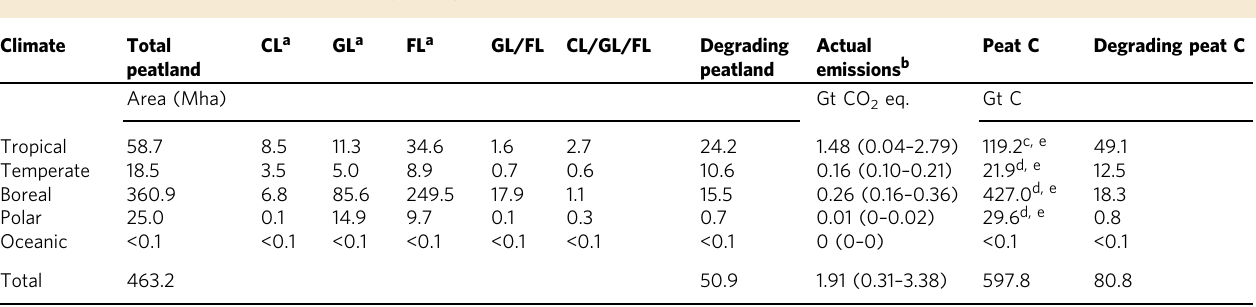
b Annual means, values in parentheses express the range from minimum to maximum. Emissions include CO 2 , CH 4 , N 2 O, and DOC c Based on refs.